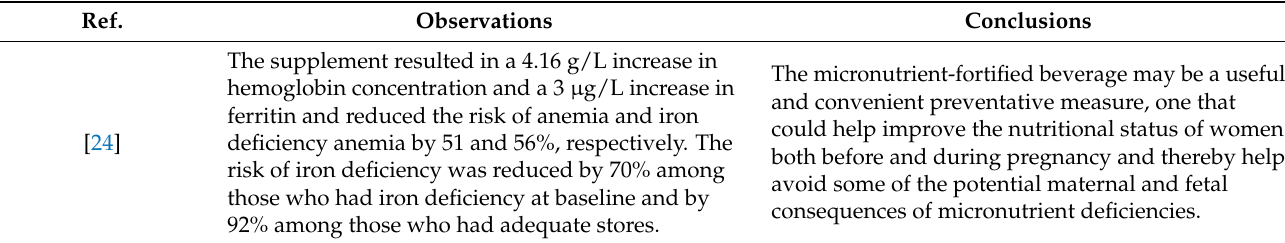
Table 6. The observations and conclusions formulated within the randomized controlled trials included in the systematic review